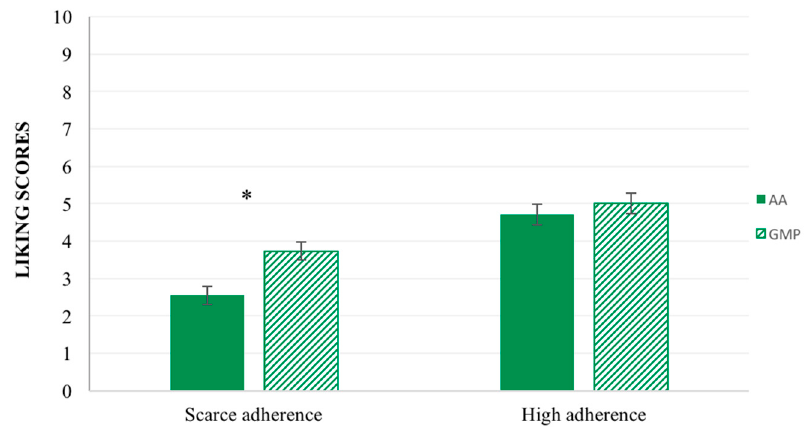
Figure 3. Liking score ± SEM by ‘adherence to diet’ × ‘samples category’. Significant difference for * p < 0.05 (Patients with scarce adherence n = 49, Patients with high adherence n = 37).